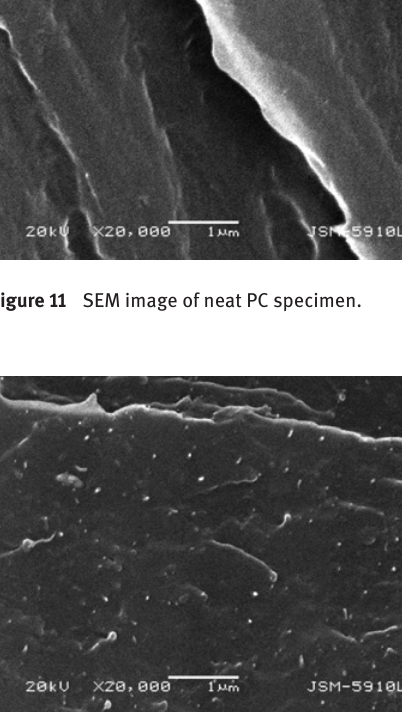
Figure 12 SEM image of C1 specimen.